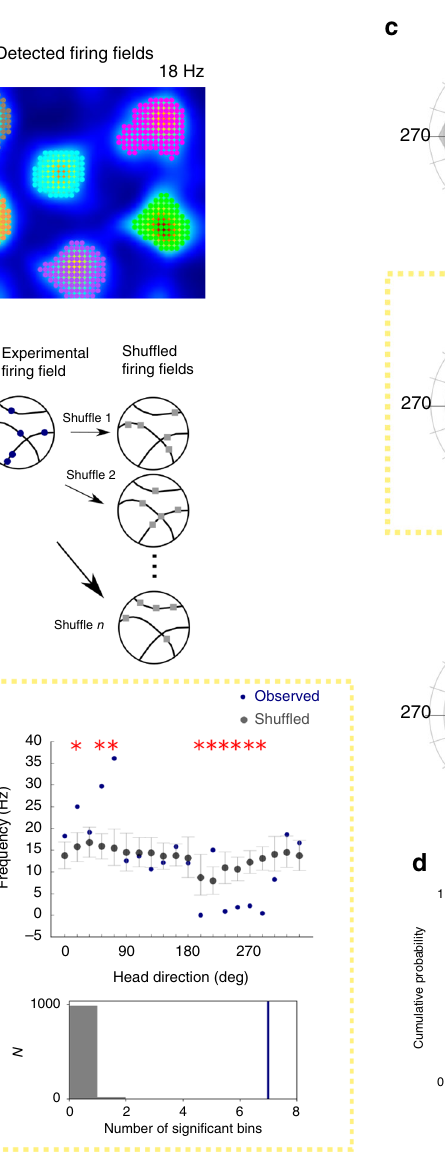
for mice: − 0.025 ± 0.31; for rats: − 0.087 ± 0.39), and the correlations between different fi elds differed from the within- fi eld correlations (for mice: D = 0.38, p = 3.3 × 10 − 6 ; for rats: D = 0.53, p = 0.018; Kolmogorov – Smirnov test). The relatively small difference here for data from rats likely re fl ects the smaller number of spikes available for the analysis. Directional fi ring remained uncorrelated between fi elds when considering only fi elds adjacent to the walls of the arena, or only fi elds in the centre of the arena, indicating that the location dependence of